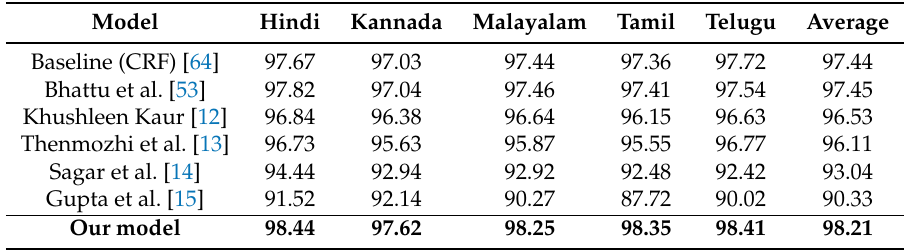
Table 3. Performance (Accuracy %) of our model in comparison with the deep learning results from the competition.